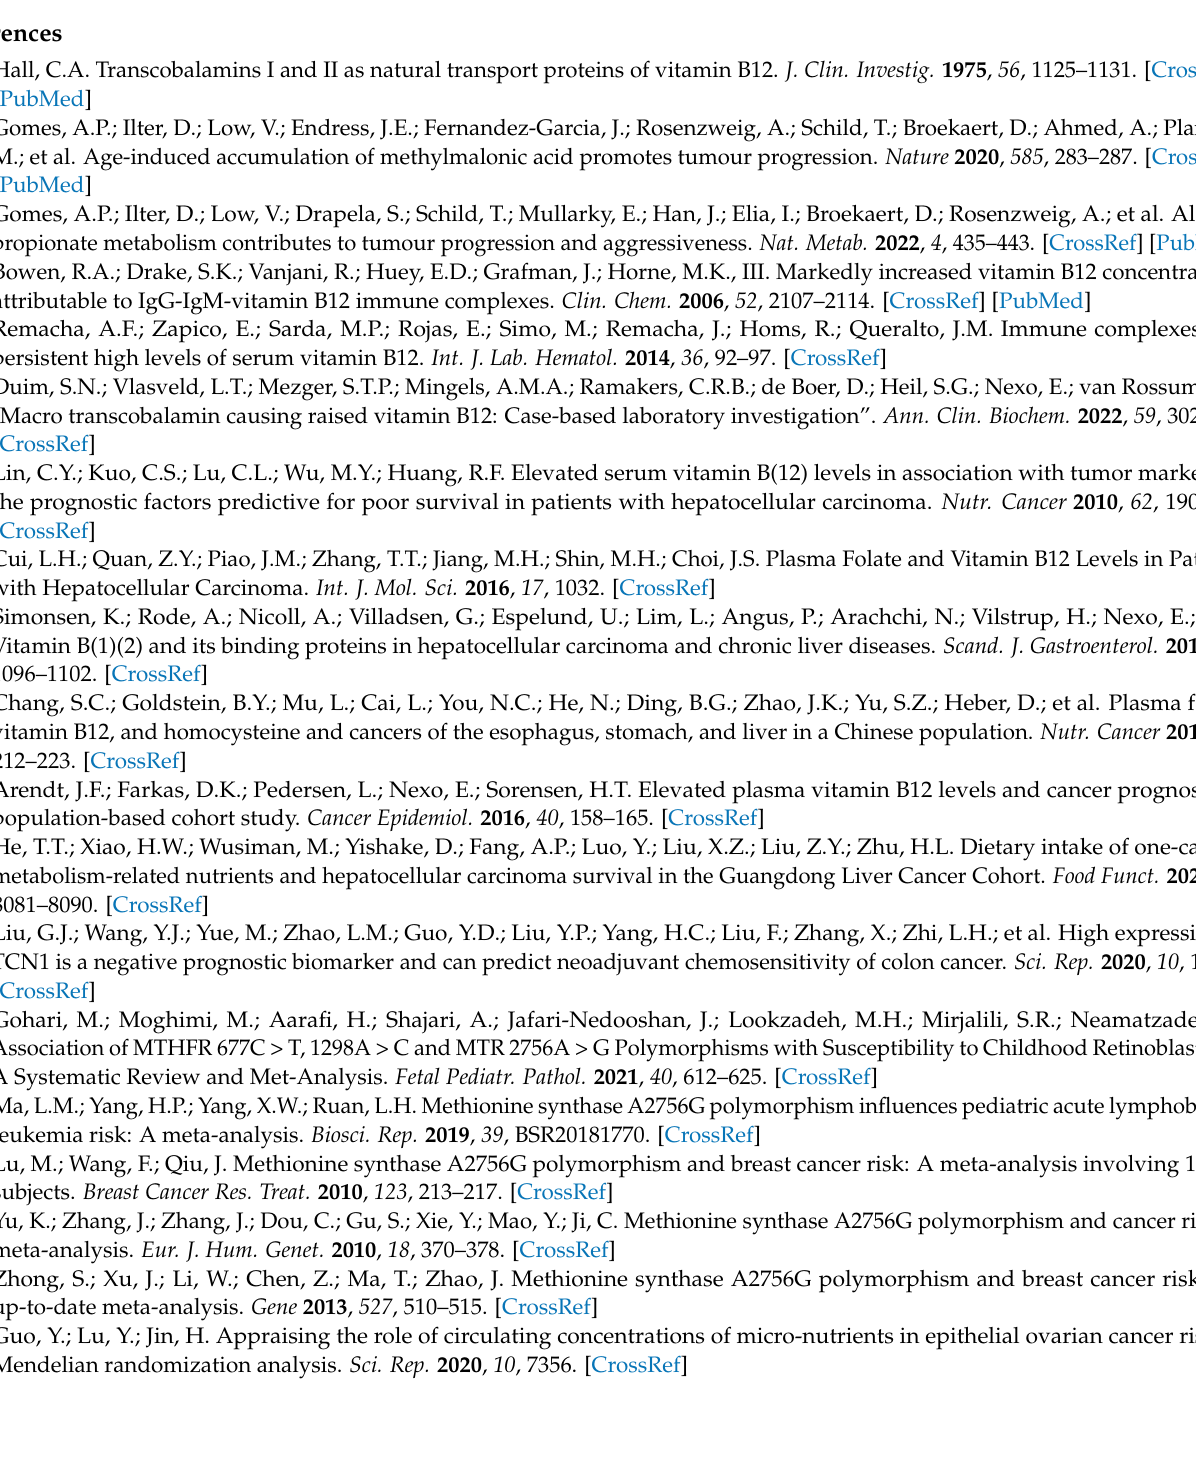
mixed types of cancer. Table S11: studies on genetic factors and mendelian randomization Table S12: randomized controlled trials on intervention including vitamin B12 and cancer or cancer-related